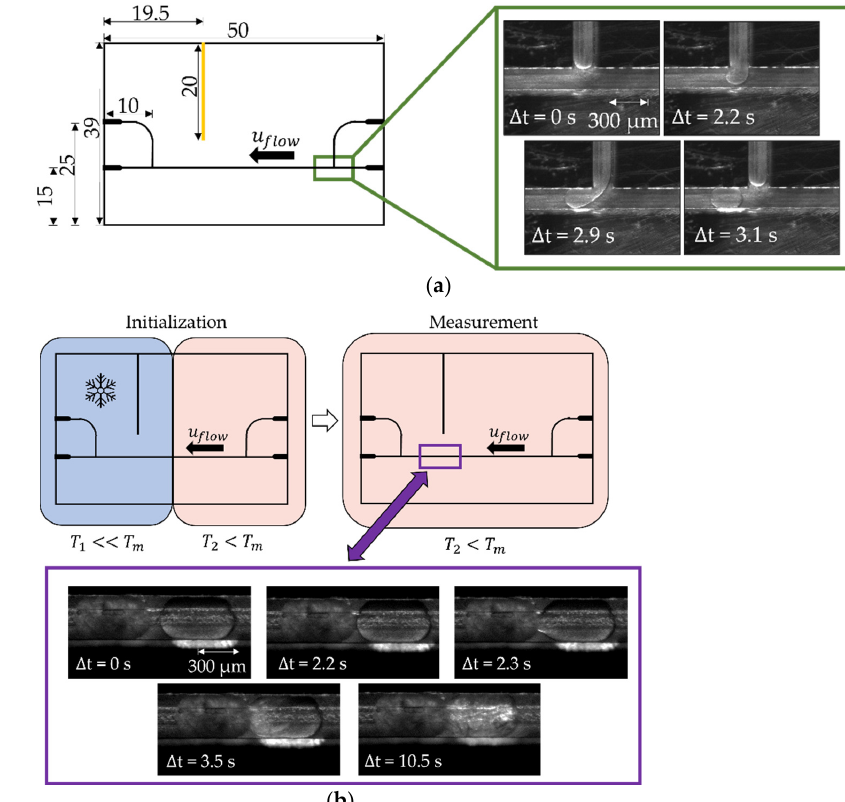
Figure 2. ( a ) Schematic view of the microfluidic chip with rectangular channels and sectional temperature regulation with scale (mm). The temperature sensor was inserted sideways into the chip through a fitting channel (yellow). The n-hexadecane droplets were formed at the T-junction (green frame) at a temperature above the melting point of n-hexadecane T m . The produced droplets flowed along the channel in the direction indicated ( u flow ) . ( b ) Half of the chip was cooled (blue area) to a subcooling of around ∆ T 1 = T m − T 1 = 7.6 K for spontaneous nucleation (initialization). The other half was kept below the melting point at ∆ T 2 = 1.1 K (red area); the droplets on this side retained liquid. The whole microfluidic chip was kept at ∆ T 2 (red area) for the contact-mediated nucleation (CMN) measurement. The purple frame exemplarily displays a time-resolved